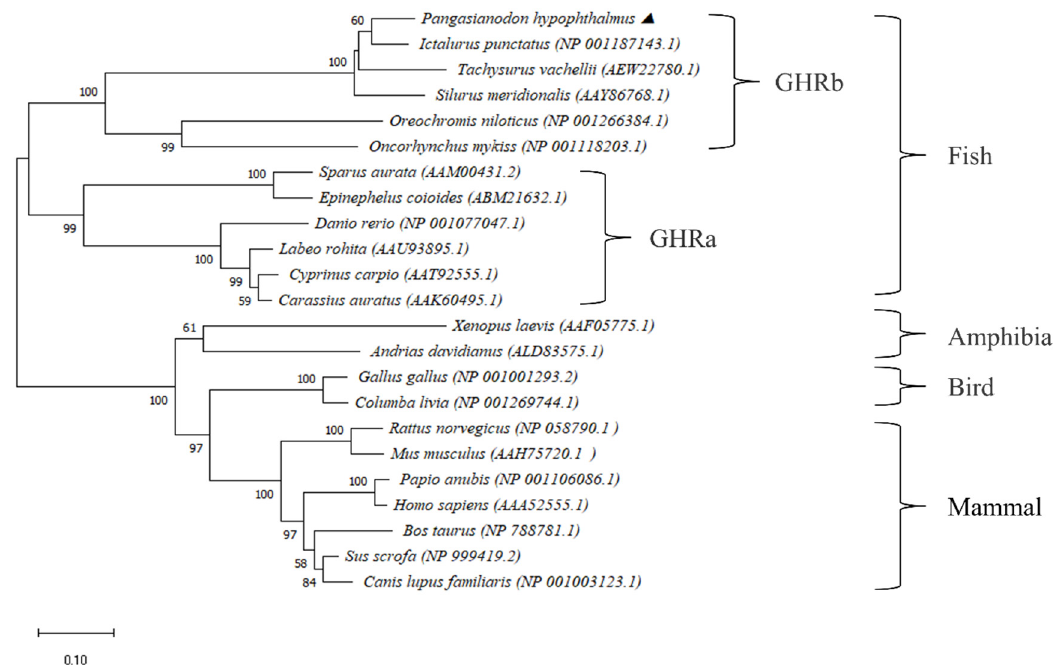
Figure 2. The phylogenetic tree of GHRb in Pangasianodon hypophthalmus with other homologous species was constructed using MEGA-X software by the N-J method.